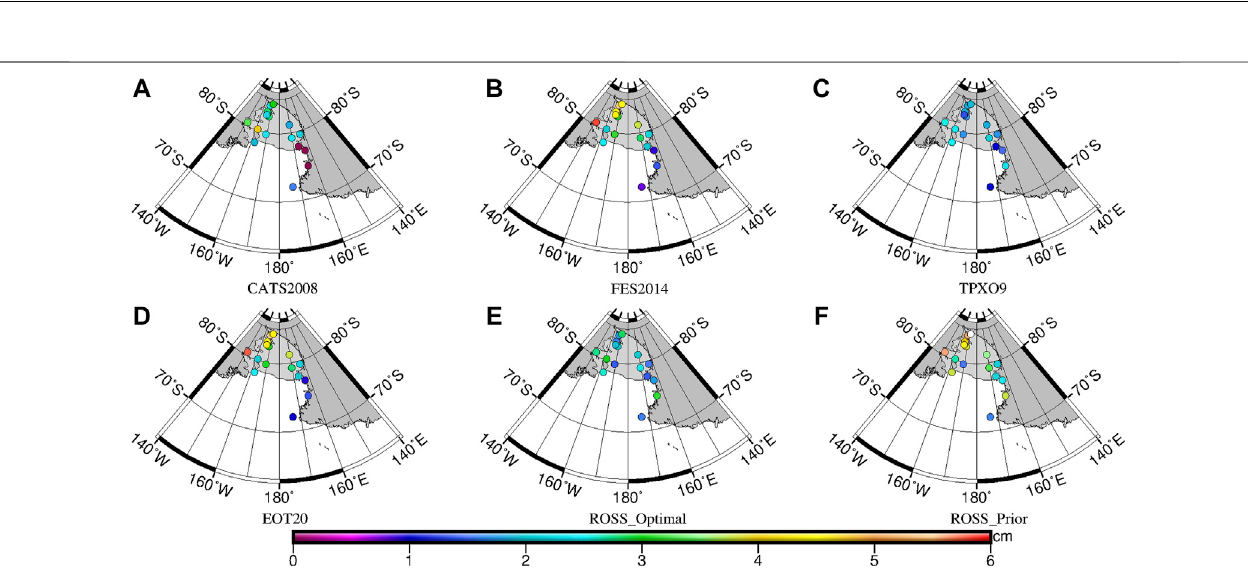
FIGURE 9 | RSS of each station of (A) CATS2008, (B) FES2014, (C) TPXO9, (D) EOT20, (E) ROSS_Optimal, and (F) ROSS_Prior in the Ross Sea and RIS.